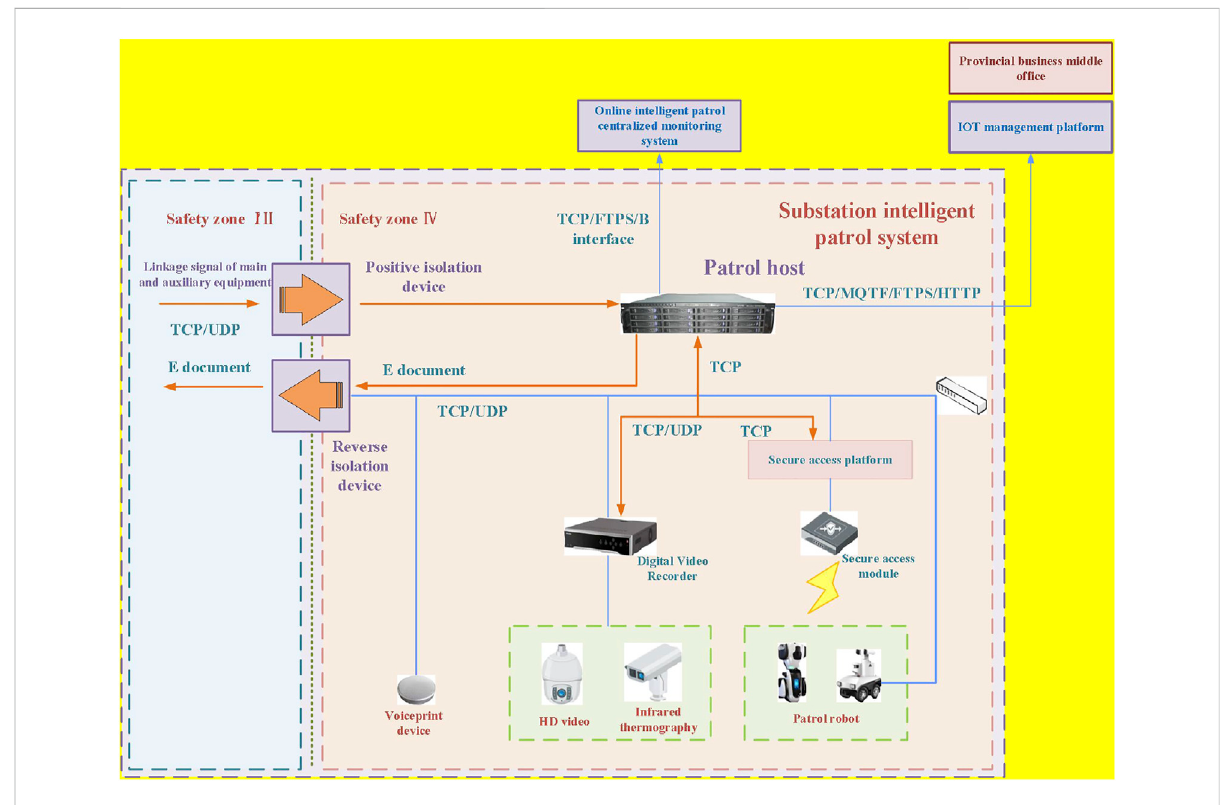
FIGURE 1 Framework diagram of substation online intelligent inspection